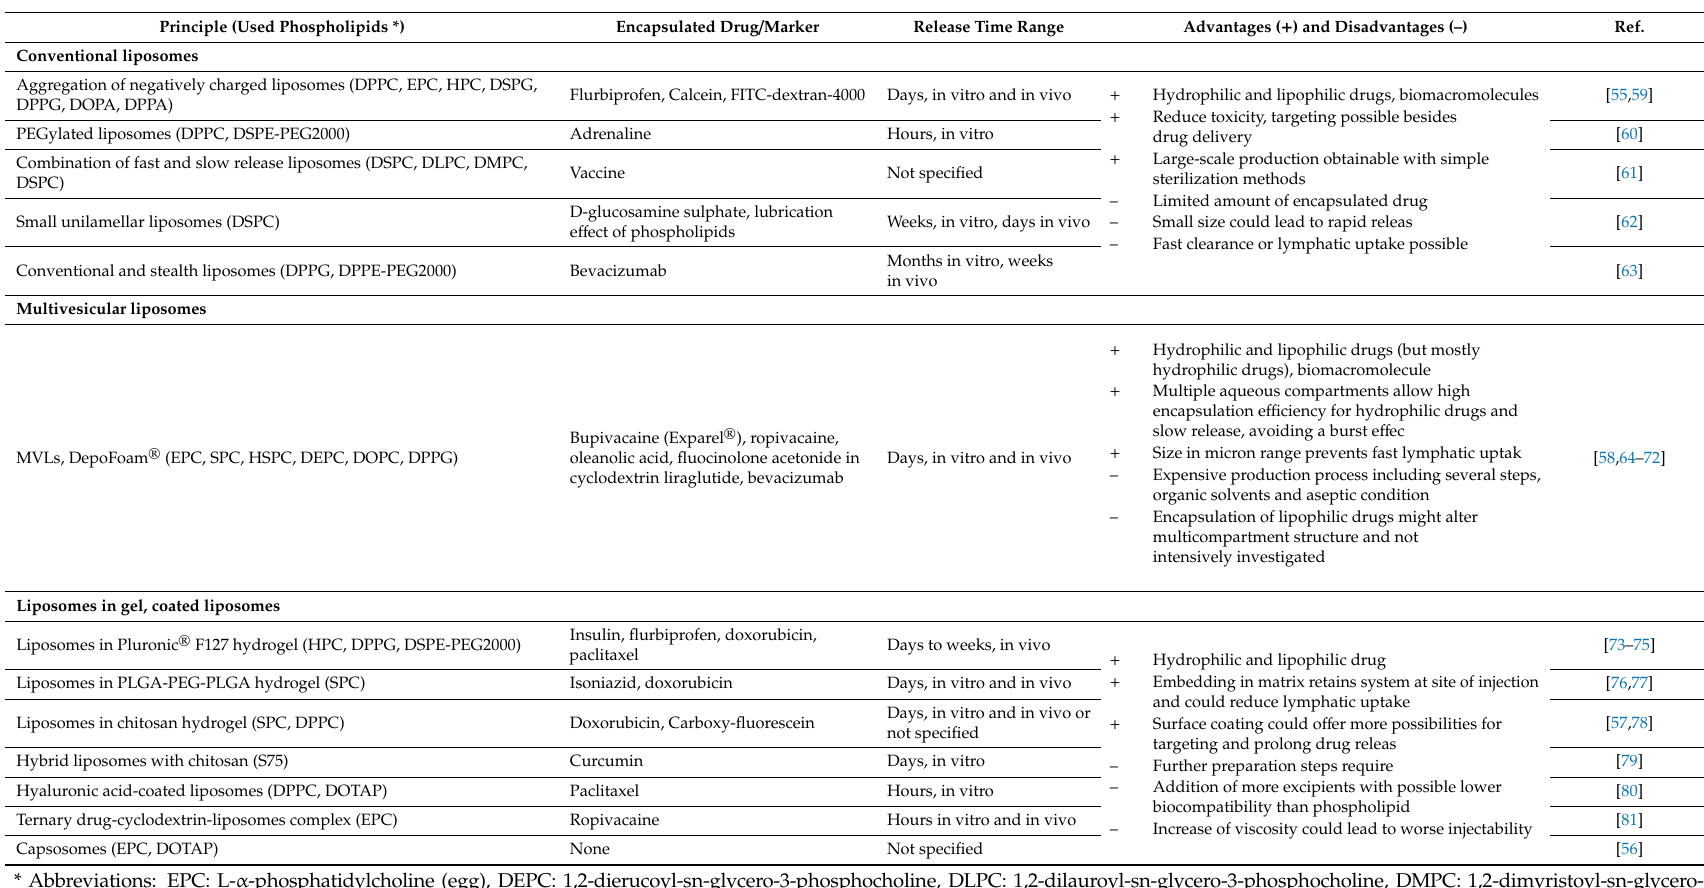
Table 3. Overview of sustained release systems based on